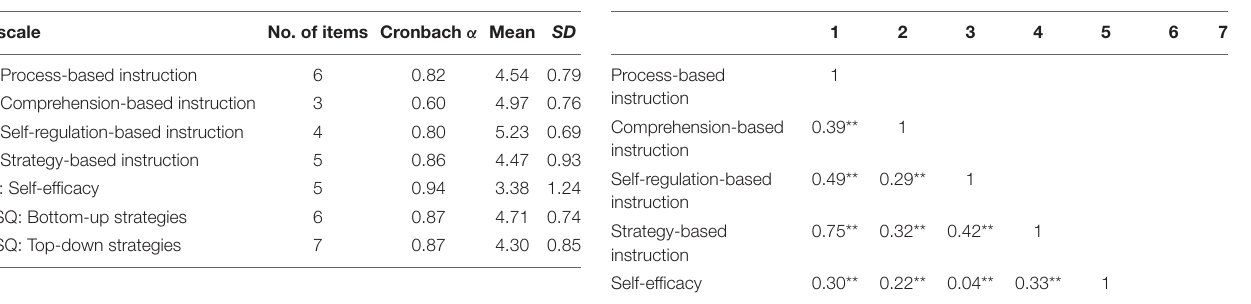
TABLE 3 | Zero-order bivariate correlations among the